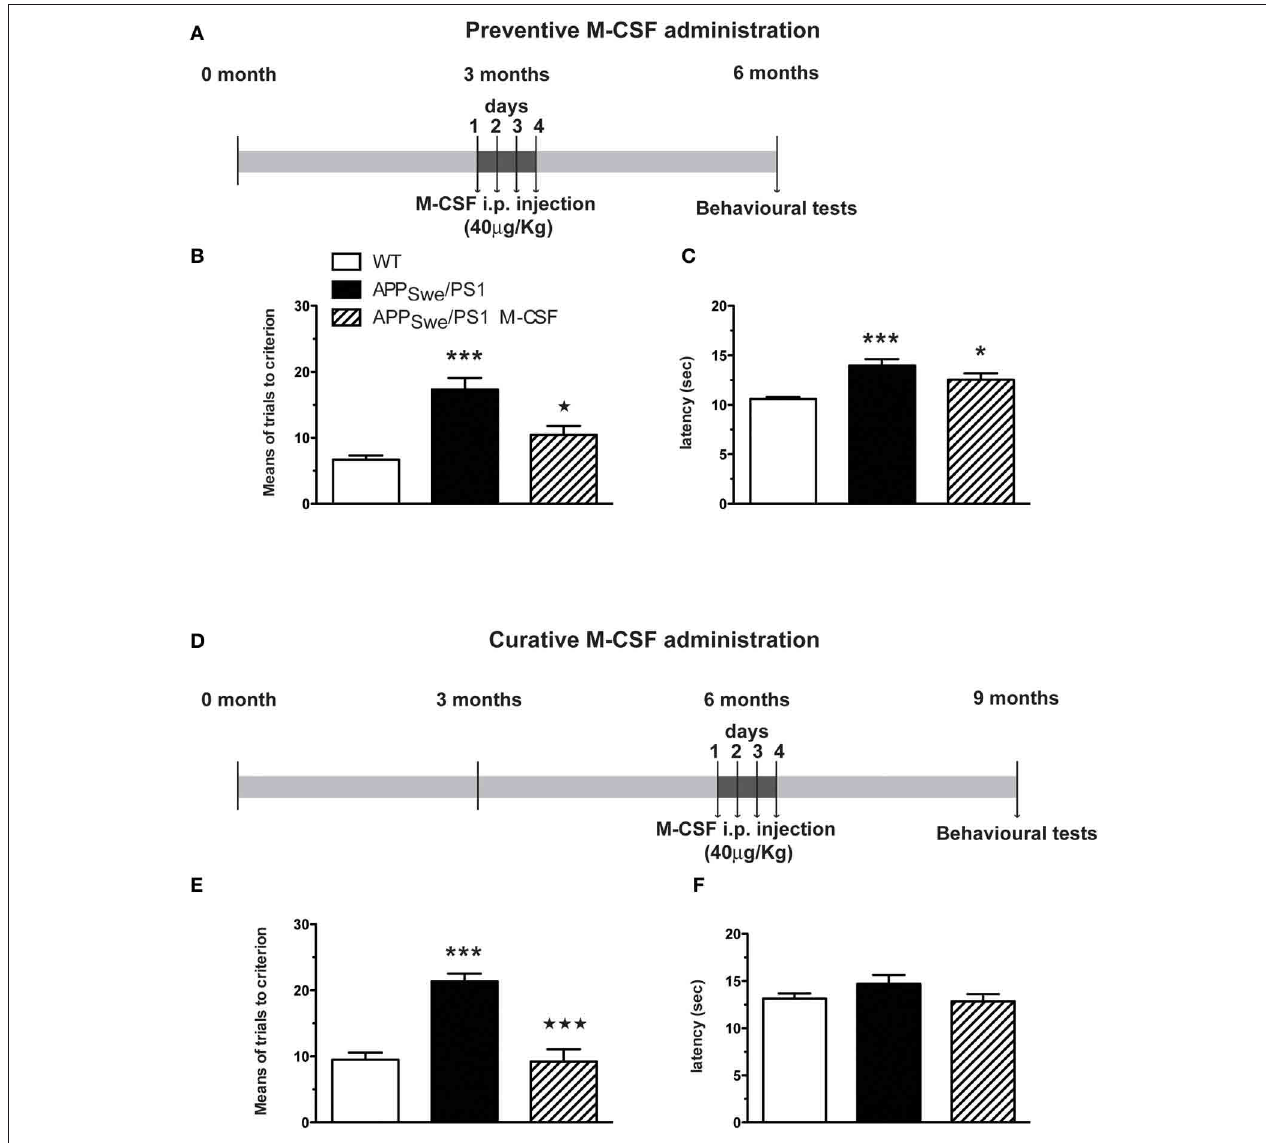
FIGURE 8 | Short M-CSF treatment is able to prevent and to rescue learning and memory impairment in APP Swe /PS1 mice. APP Swe /PS1 mice received M-CSF treatment during 4 days (40 μ g/Kg/day) before (at 3 months) or after occurrence of mnesic deficit (at 6 months) and were tested in the T water-maze paradigm 3 months later (A) . The numbers of trials (B and E) and the latency (C and F) to accomplish the task were determined during reversal learning phase. M-CSF treatment prevented